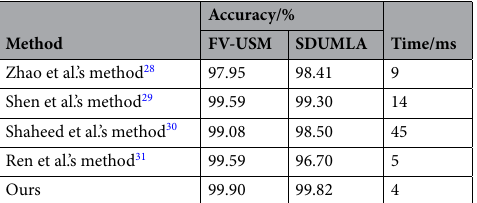
Table 5. Experimental results of deep learning models.